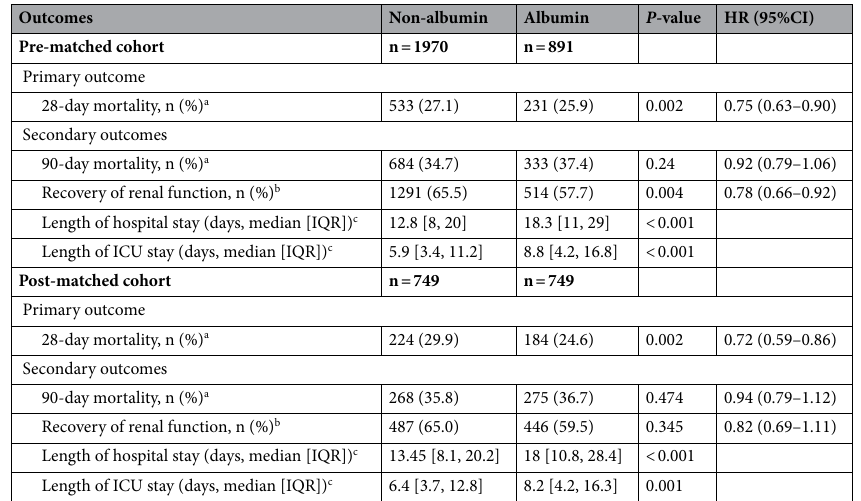
Table 2. Association between albumin infusion and clinical outcomes in patients with septic shock and acute kidney injury. IQR interquartile range, ICU intensive care unit, HR hazard ratio, CI confidence interval. a Cox proportional hazard models were used to assess the impact of albumin infusion on mortality outcomes adjusting for confounders selected from P- value < 0.05 in univariate analysis. b Recovery of renal function was defined as being discharged from ICU with serum creatinine below 1.5 times the baseline value and normal urine output (> 0.5 ml/kg/h). Impact of albumin infusion on the recovery of renal function was assessed using the logistic regression model adjusting for age, SAPSII score, and RRT use. c Wilcoxon rank sum test was used to assess the association between albumin infusion and length of